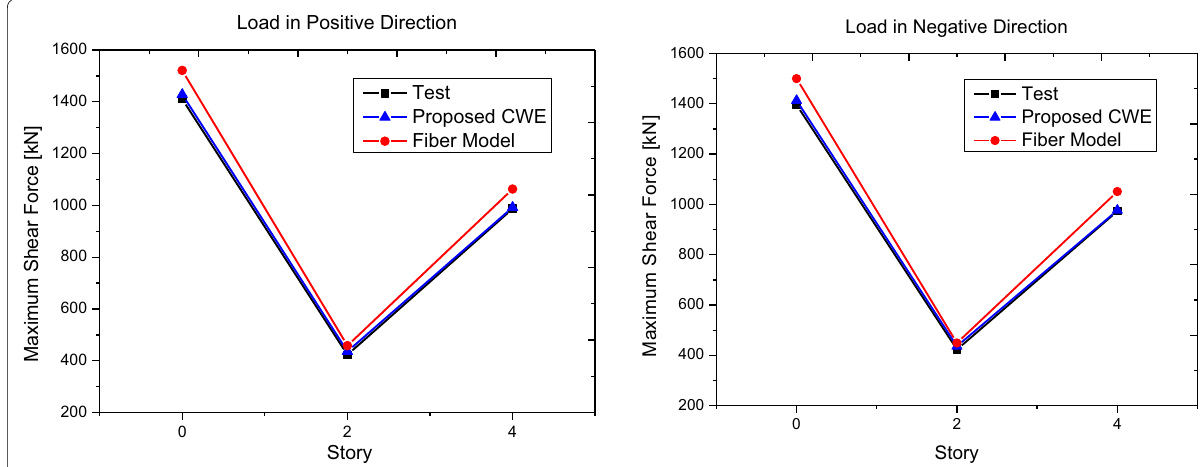
Fig. 21 Comparisons of maximum shear forces of CW-1using the experimental data, proposed CWE, and fiber models.